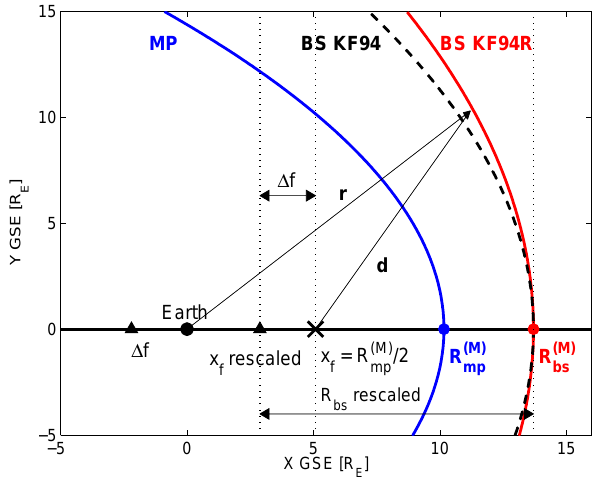
Fig. 1. A schematic representation of the parameters used in the for- mulation of the KF94 model and in rescaling from KF94 to KF94R. Note that 1f is negative in this case, as the focus x f is being shifted anti-sunward to decrease the curvature of the model